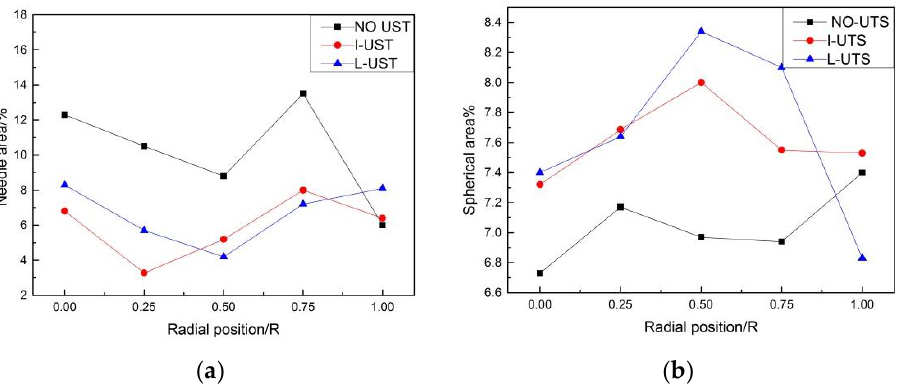
Figure 9. Of precipitated phase areas in different shapes: ( a ) needle area; ( b ) spherical area.